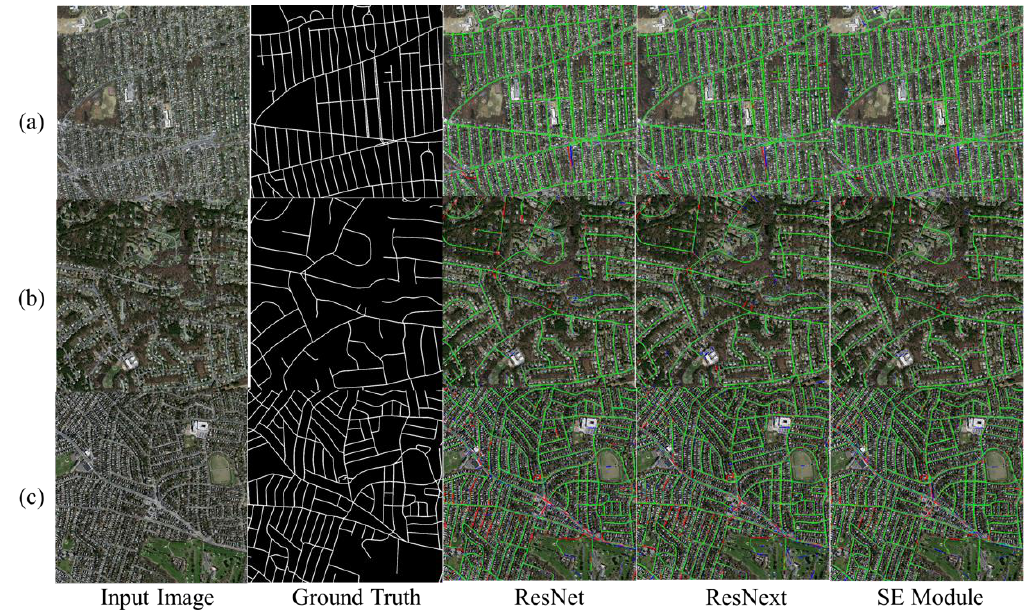
Figure 10. Visual comparison of three backbone networks used in Nested SE-Deeplab for the testing set. True positive (TP) is marked as green, false positive (FP) as blue, and false negative (FN) as red. The three rows including ( a ), ( b ) and ( c ) in the figure represent visual effects of three examples in testing set, which have been tested by different models. For each row in the figure, it contains an input image, a picture of ground truth and results of the proposed model combined with different backbone networks including ResNet, ResNext and SE Module.